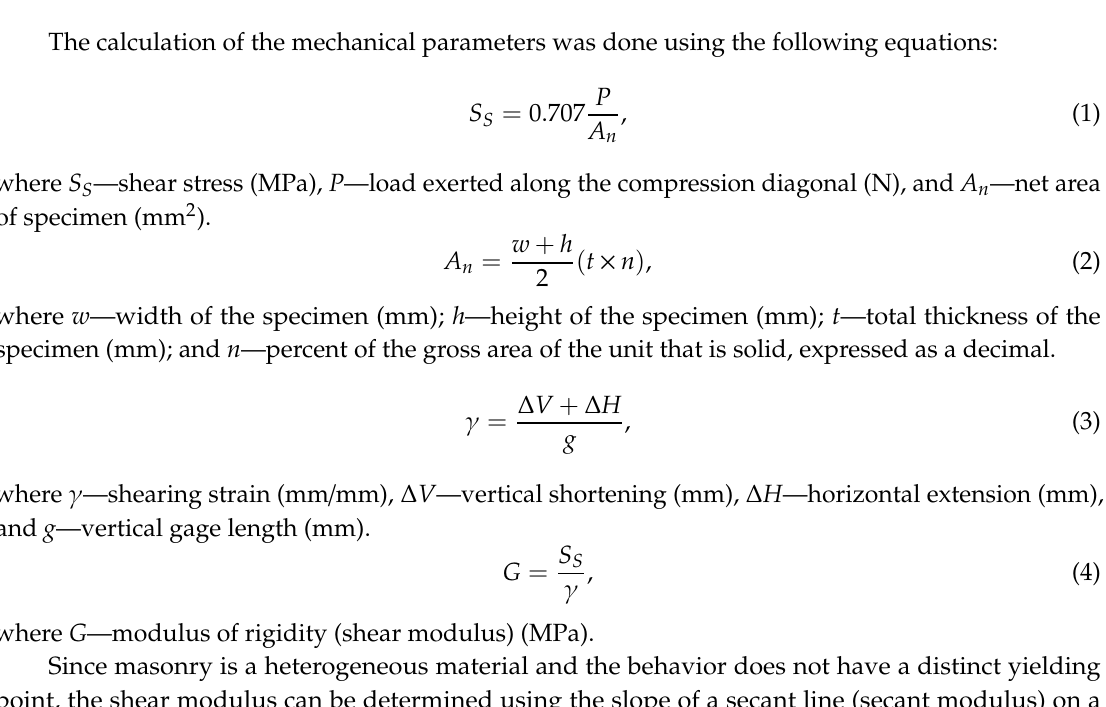
Figure 9. Diagonal compression test setup: ( a ) half-size wall panel and ( b ) full-size wall panel.